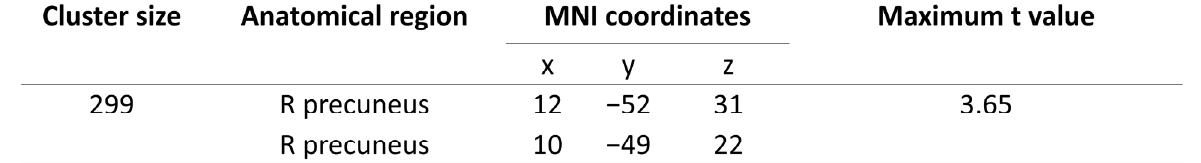
Figure 2. GMV difference between OSA and NC groups. Voxel-wise group comparisons of GMV be- tween the OSA and NC groups show increased GMV of the right precuneus in the OSA group. There were no regions with decreased GMV in the OSA group compared to the NC group. Abbreviations: R: right; L: left; MNI: Montreal Neurological Institute.